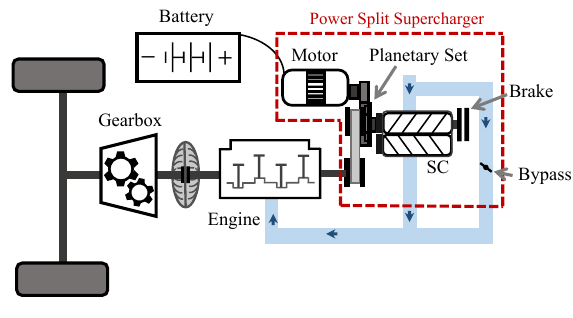
Figure 1. Powertrain schematic with a power split